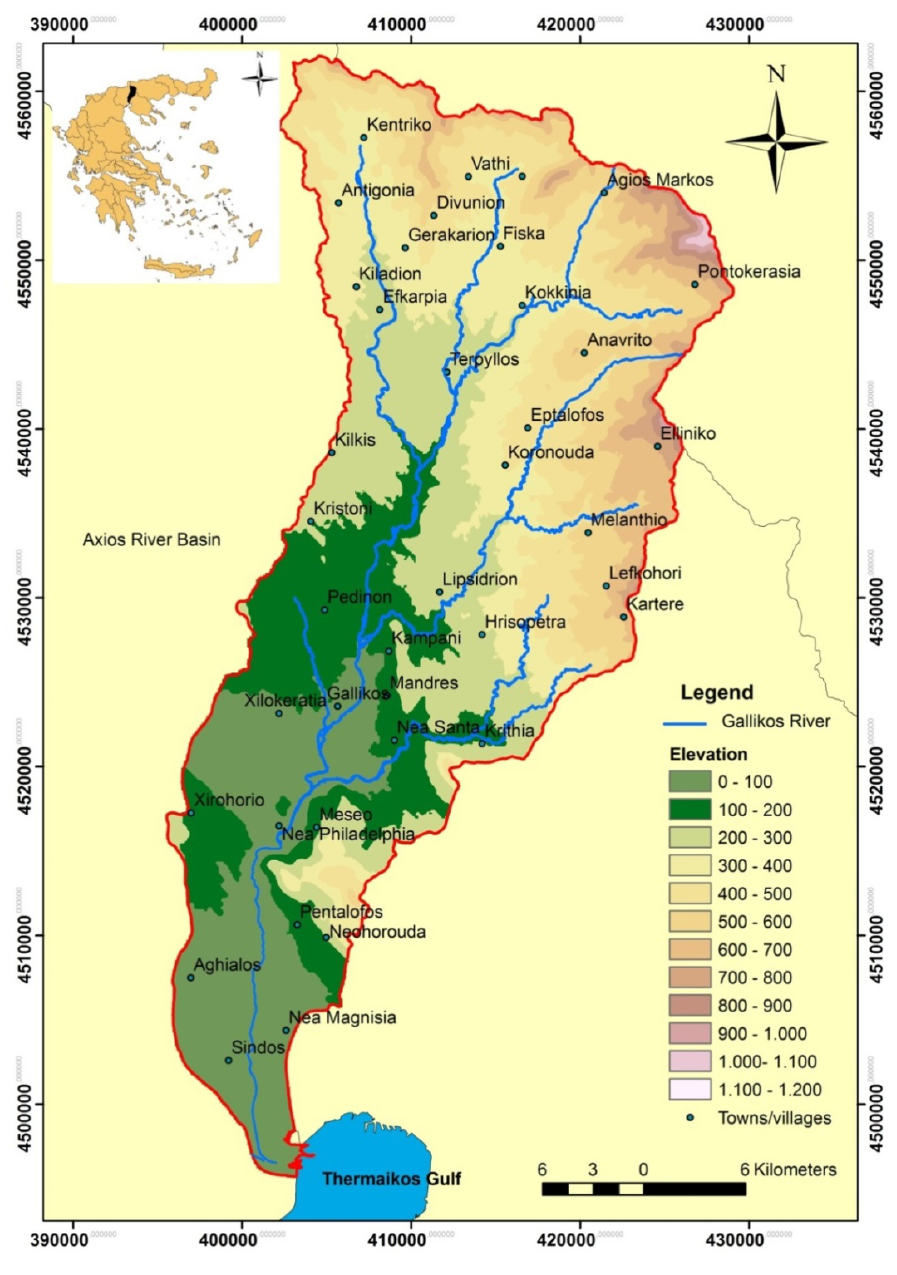
Figure 1. Topographic map of the Gallikos River